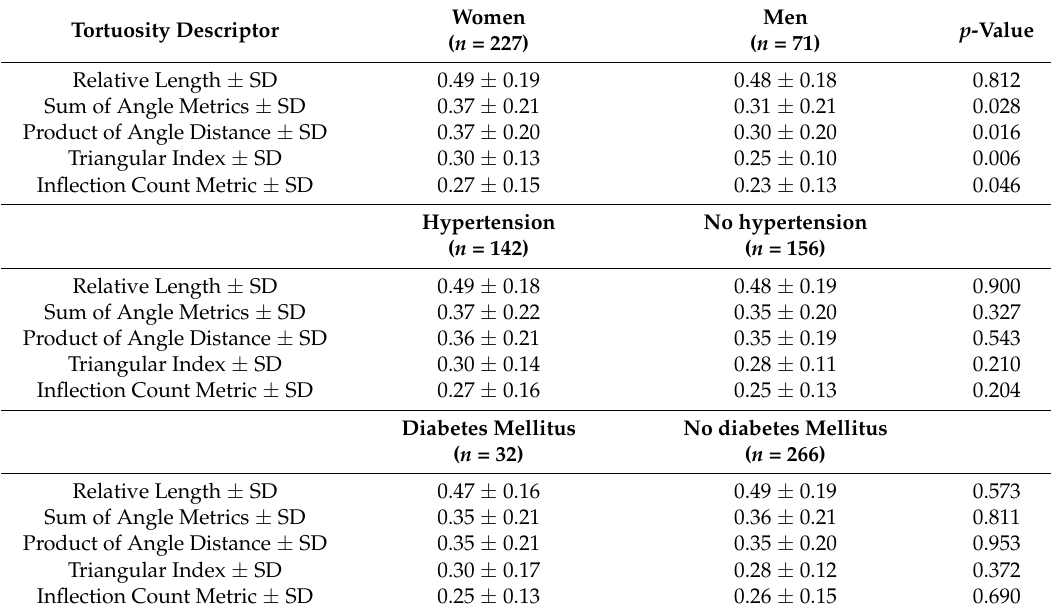
Table 2. Association of intracerebral aneurysm development risk factors with internal carotid tortuosity descriptors.